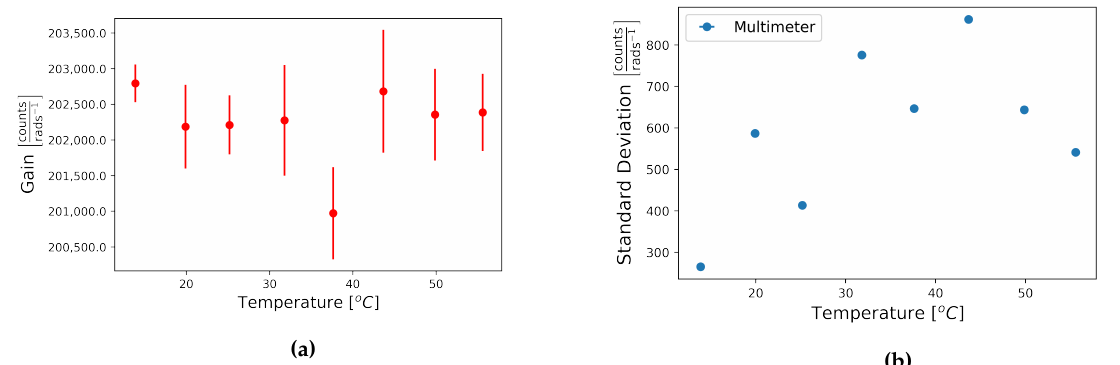
Figure 9. Plots of ( a ) the mean tilt table scale factors and ( b ) the standard deviations of the tilt table scale factors from sixteen steps taken with sensor number 0347 as a function of temperature recorded with the multimeter.